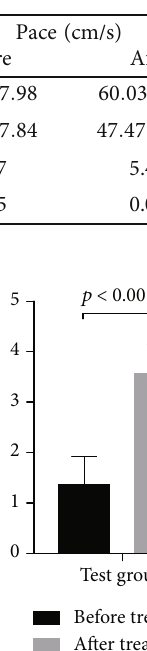
Table 3: Change of the tibial anterior muscle iEMG, the pace, and the step length asymmetry.